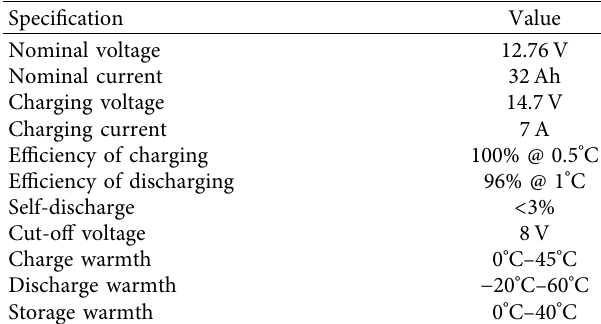
Table 1: Storage specification.